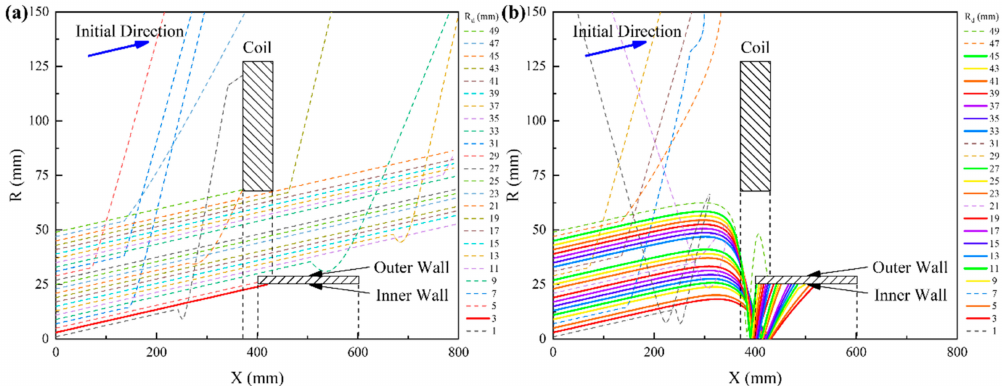
Figure14. Influenceofion-neutralelasticcollisiononthetrajectoriesofionsunderdi ff erentcharacteristic magnetic flux densities: ( a ) 0 Gs; ( b ) 1840